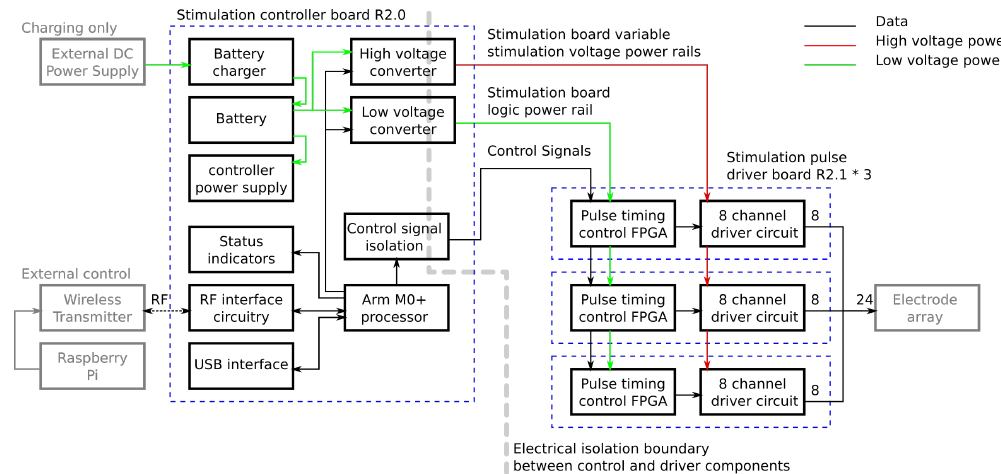
Figure 4. Block diagram of stimulator